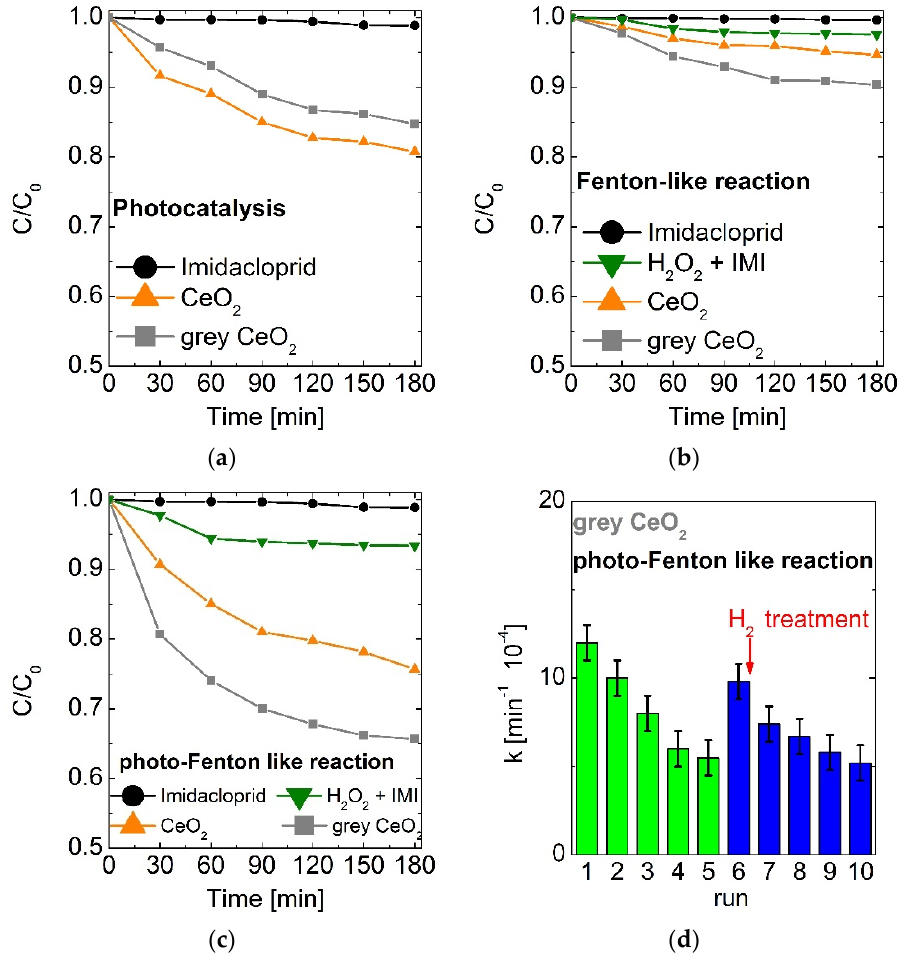
Figure 6. ( a ) Photocatalytic degradation of imidacloprid (IMI) under solar light irradiation, ( b ) Fenton-like reaction, ( c ) photo-Fenton like reaction on the CeO 2 -based samples, ( d ) photo-Fenton like reaction utilizing grey CeO 2 in different runs.